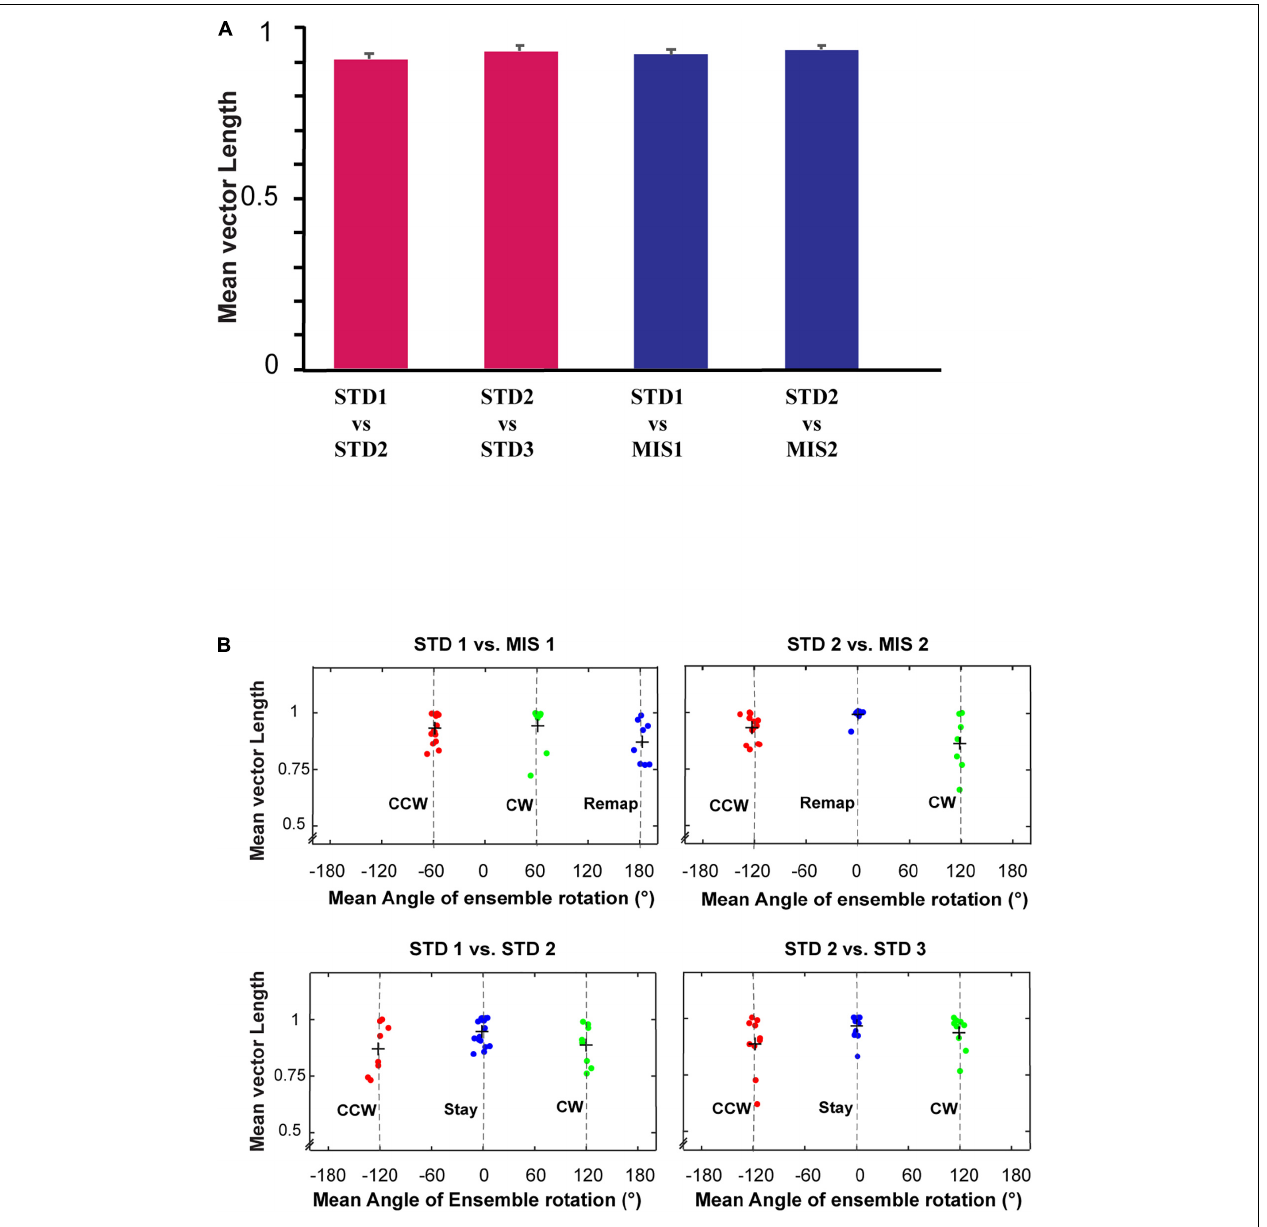
FIGURE 8 | Mean vector length distribution and dynamics of place cell orientation. (A) Mean vector length of co-recorded cells (ensemble) in different standard and mismatch comparisons. An error bar indicates the standard error of mean. (B) A scatter plot of the mean direction and mean vector length of all the ensembles across standard and mismatch sessions. Red, green, and blue dots show the clustering of the data points based on k-means elbow method. “+” indicates the centroid of each cluster. In standard vs. mismatch comparisons, the red cluster signifies the ensembles that followed the rotation of CCW reward flavors (CCW), the green cluster signifies the ensembles that followed the rotation of CW distal cues (CW), and the blue cluster signifies the ensembles that rotated away (Remap), not following either reward flavors or distal cues. In standard vs. standard comparisons, the red cluster signifies the ensembles that followed the net CCW rotation (CCW), the green cluster signifies the ensembles that followed the net CW rotation (CW), and the blue cluster signifies the ensembles that showed a stable representation between standard sessions (stable). Gray-dotted line denotes the angle of separation of spokes/cues (120 ◦